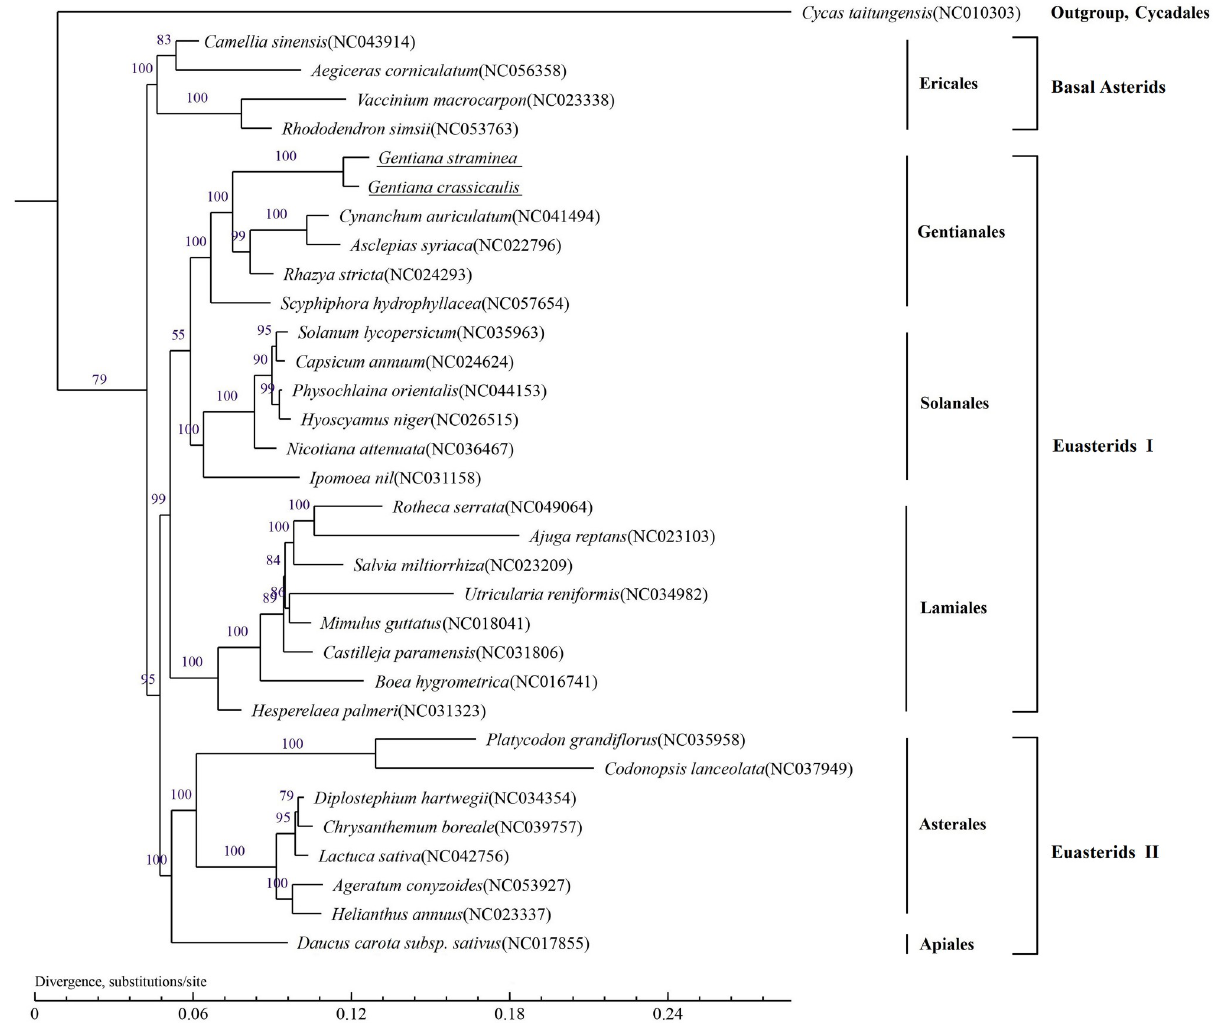
Fig 9. Molecular phylogenetic tree of 33 species based on the complete mitochondrial genomes. The tree was constructed via a maximum-likelihood analysis using PhyML 3.0 with 1000 bootstrap replications.